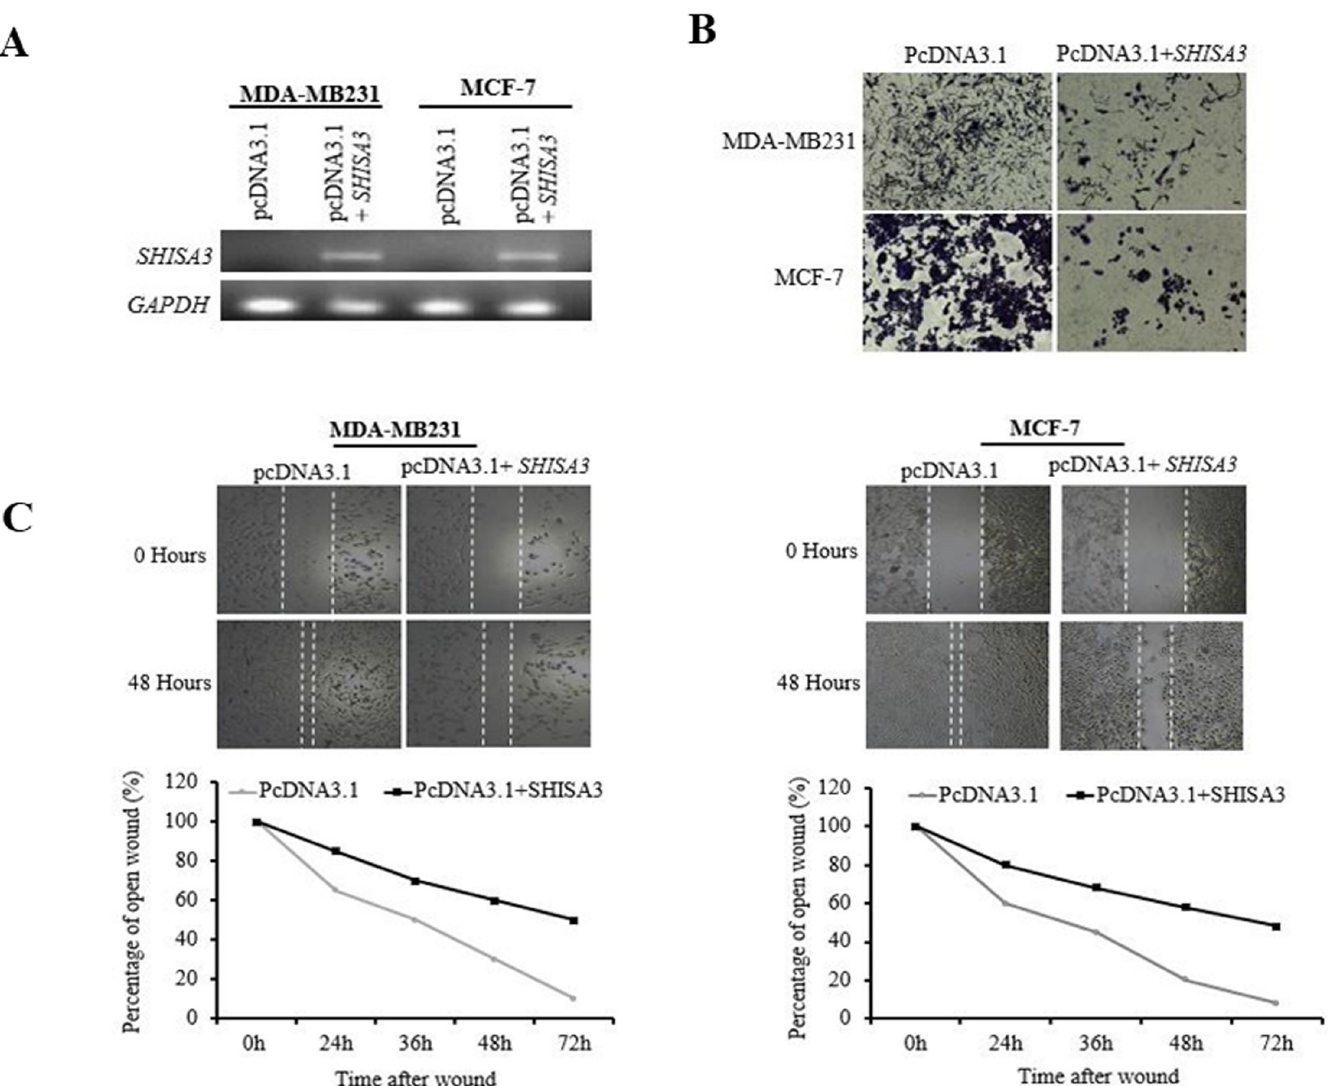
Fig 4. Breast cancer cells proliferation and migration abilities before and after SHISA3 ectopic expression. A) qPCR of SHISA3 expression in control (pcDNA3.1) and pcDNA3.1- SHISA3 transfected MDA-MB231 and MCF-7 cells. GAPDH was used as internal control for normalized gene expression. B) Cell proliferation assay of MDA-MB231 and MCF-7 cell before and after transfection of SHISA3 . C) Wound-healing assay for cell motility of empty vector- or SHISA3 -expressing vector transfected MDA-MB231 and MCF-7 cells. Upper: Representative images of wound sealing at 0 h or 48 h after wound scratch. Lower: percentage of wound sealing compared with that of controls at each time point as